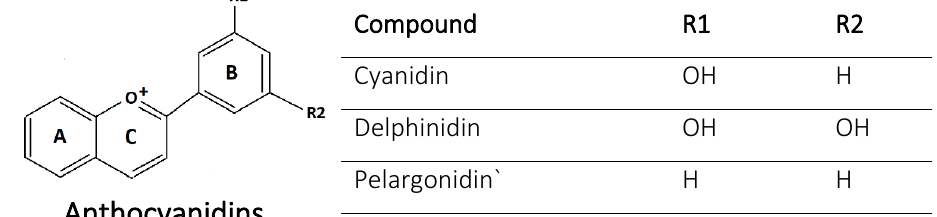
Figure 7. Flavanols: chemical structure, types and substitution positions in the basic skeleton.